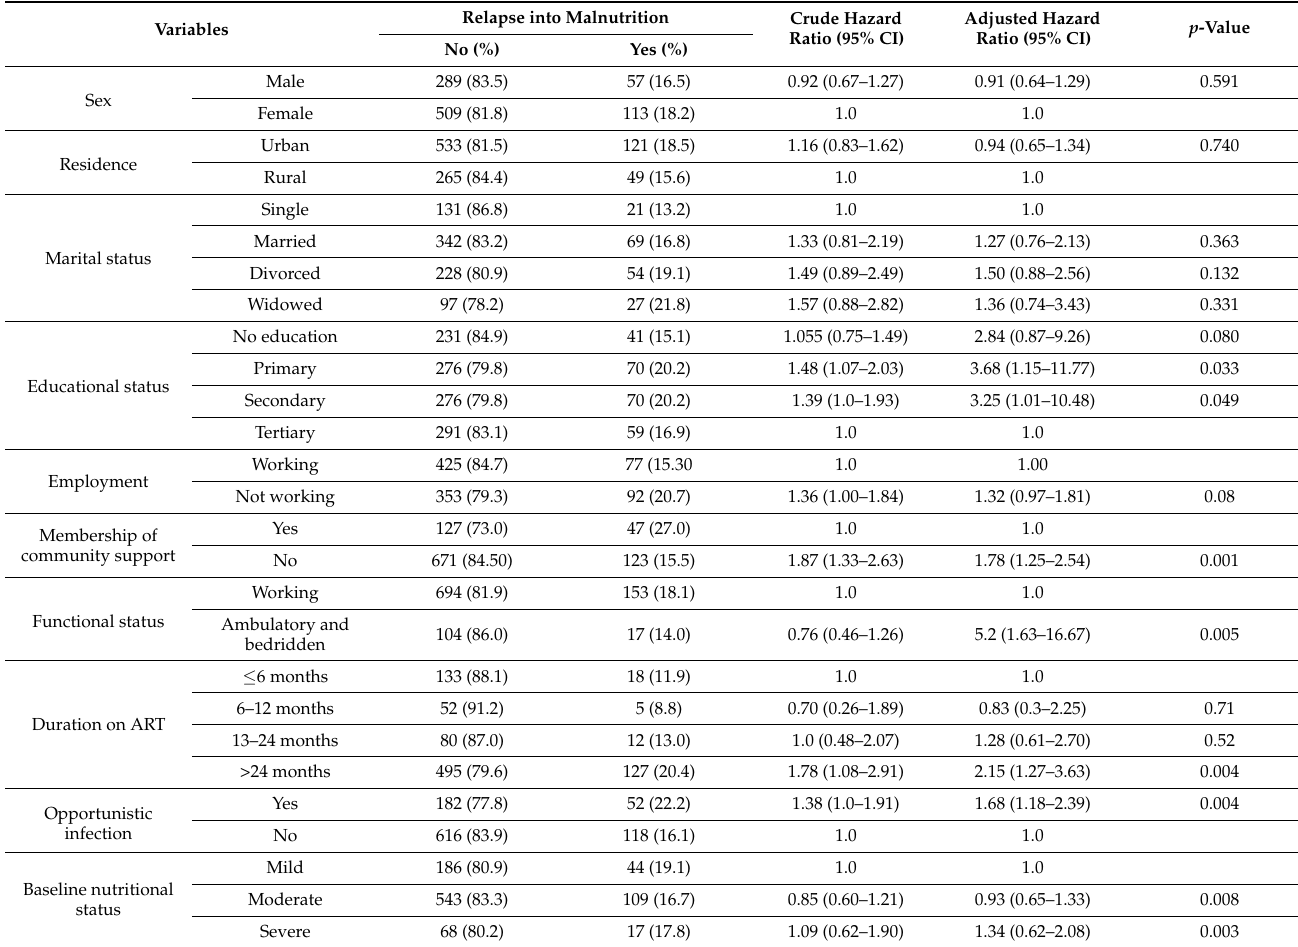
Table 4. Determinants of relapse into undernutrition after nutritional recovery in